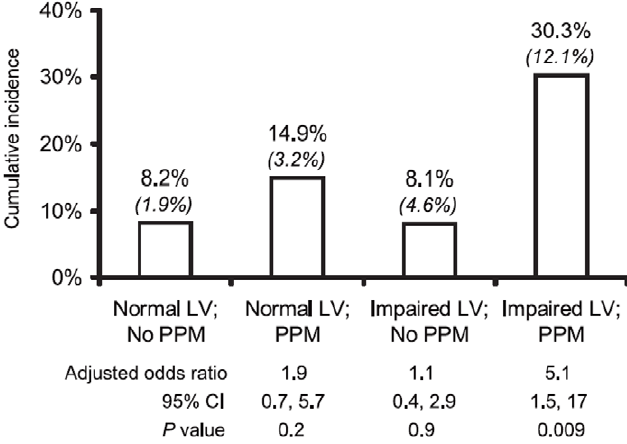
Figure. 7 Effect of preoperative left ventricular function and prosthesis-patient mismatch (PPM) on the cumulative incidence of heart failure symptoms or death related to heart failure at three years after aortic valve replacement. Nonitalic percentages, bars, and odds ratios refer to the occurrence of either heart failure symptomsordeath.Italicpercentagesinparenthesesindicateheartfailuredeath.Oddsratiosareincomparison to the ‘Normal LV; No PPM’ group and are adjusted for risk factors of decreased freedom from heart failure after aortic valve replacement and for baseline patient characteristics. Patients with the combination of impaired preoperative left ventricular function and postoperative PPM had a lower freedom from heart failure despite adjustment for confounding factors. CI, Confidence interval; LV, left ventricle. (Reproduced and modified with permission from [63]).